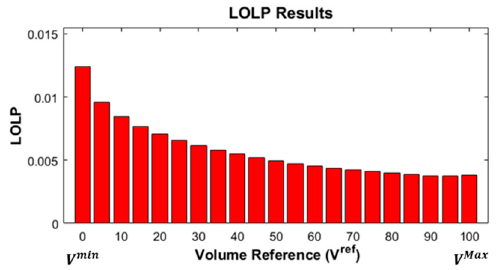
Figure 13. Loss of load probability ( LOLP) Results According to Values of V ref .